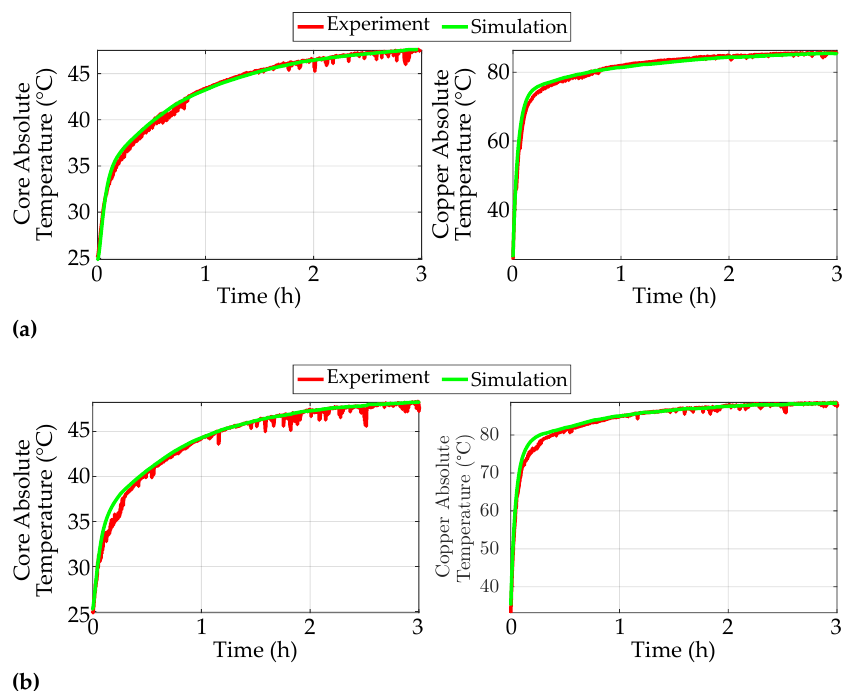
Figure 14. LSFPM thermal test result vs model response. ( a ) Horizontal test. ( b ) Vertical